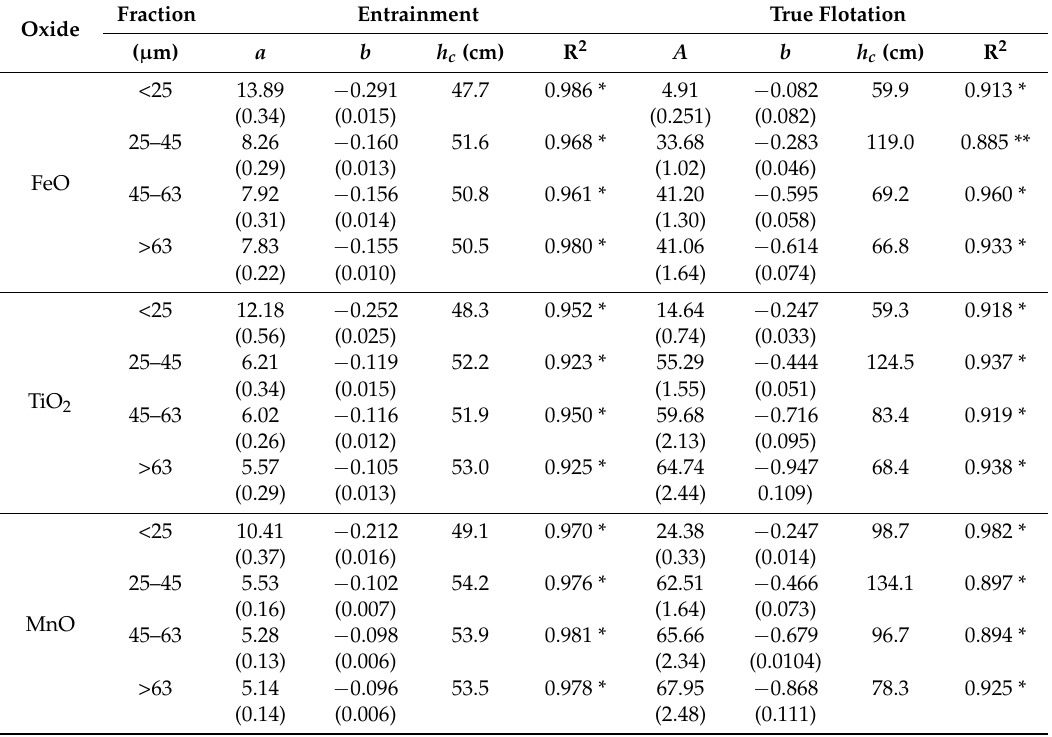
Table 5. Linear regression coefficients ( a and b ), critical froth heights ( h c ), Standard error associated with the calculation of the slope and the intercept of the curve between parentheses, R-squared ( R 2 ) and significance levels * of the oxides recovery by entrainment and true flotation of the four size fractions. Fraction Entrainment True Oxide